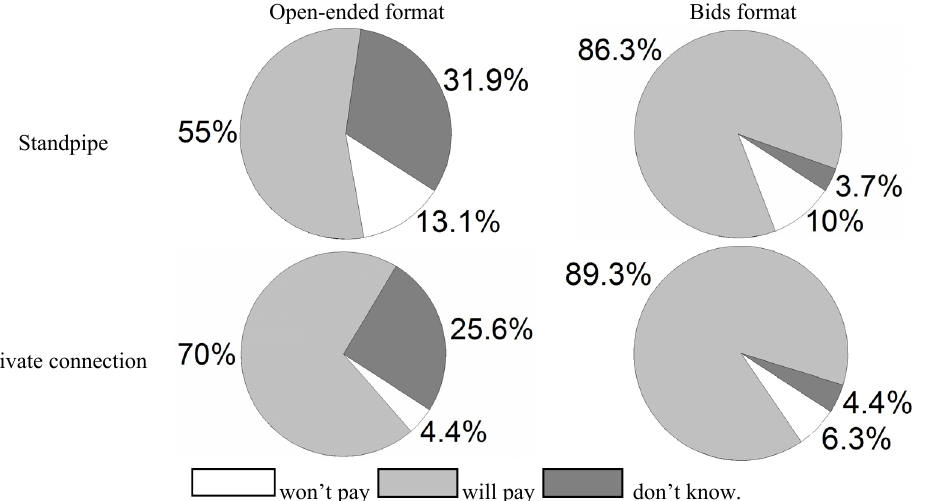
Figure 2. Answer rate to open-ended and bids format questions for standpipe and private connection, respectively.